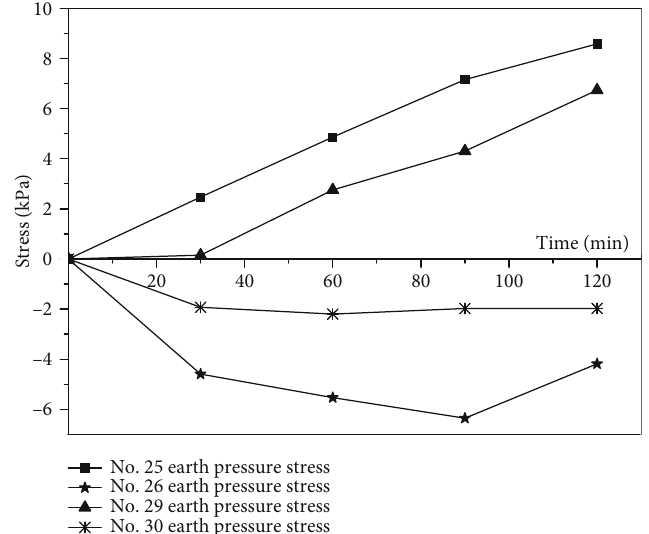
Figure 11: Typical section soil pressure evolution.